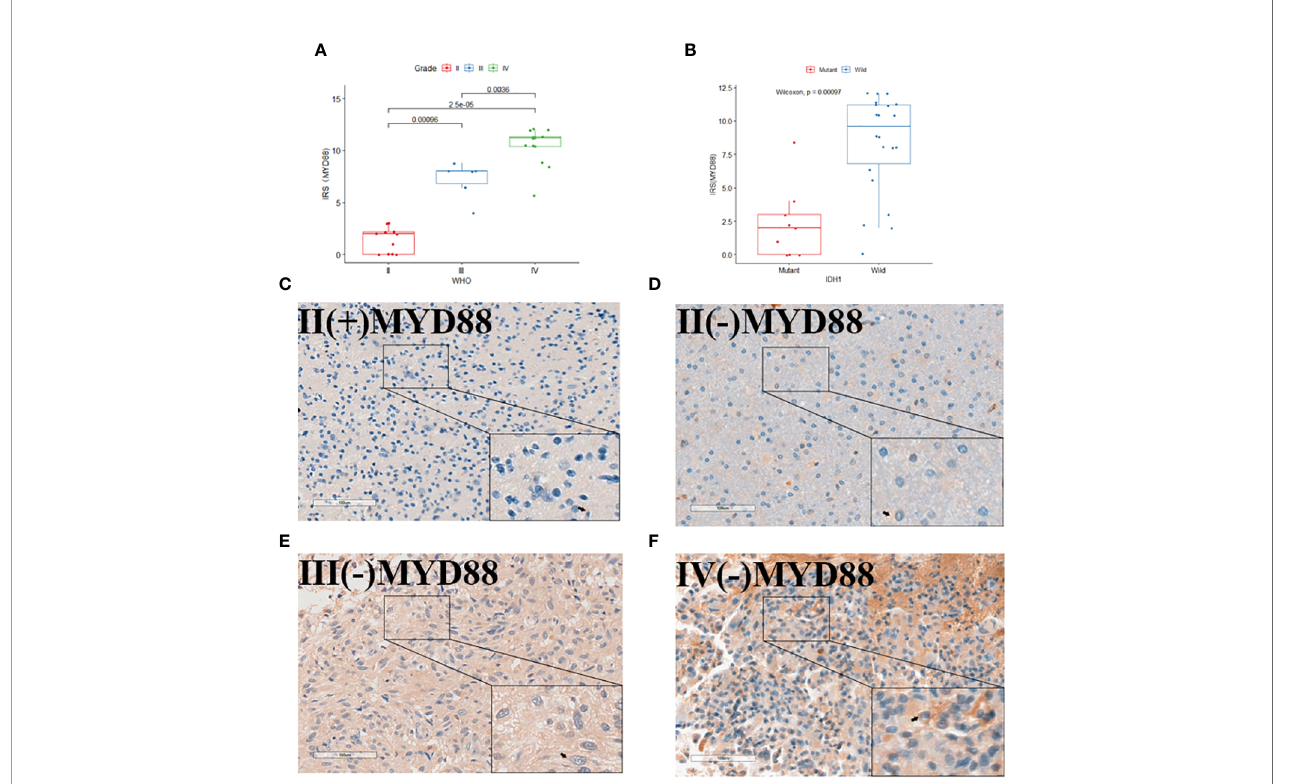
FIGURE 7 | The MYD88 IHC staining of the 31 glioma patients. (A) MYD88 expression was signi fi cantly higher in high-grade gliomas. (B) In the IDH1 mutant cases, the MYD88 was signi fi cantly lower as compared to the cases with IDH1 wild cases. (C – F) IHC image of example glioma patients with WHO grade II/IDH1(+), WHO grade II/IDH1 ( – ), WHO grade III/IDH1 ( – ) and WHO grade IV/IDH1 ( – ) pathology results